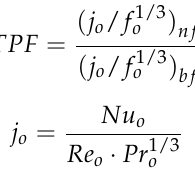
Table 3. Predicted values and deviations of the